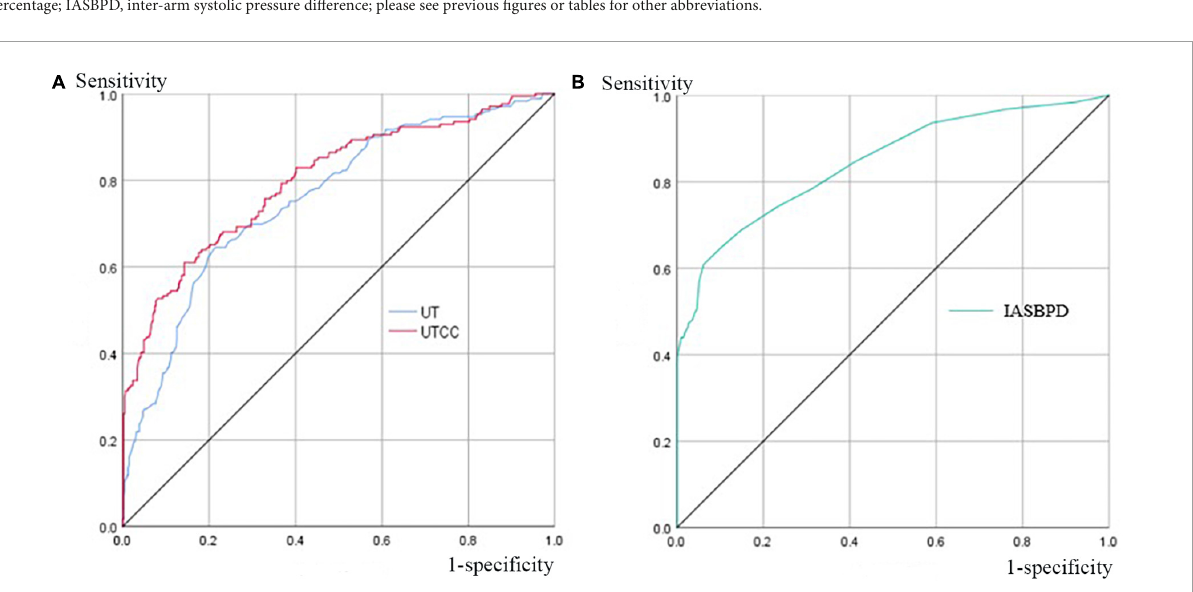
FIGURE3 Area under the curves (AUCs) of UT, UTCC, and IASBPD when SAS ≥ 50%. Panel (A) the UT and UTCC curves when SAS is equal to or greater than 50%, and their corresponding AUC is 0.76 (95% CI: 0.72–0.80) and 0.80 (95% CI: 0.76–0.85) for UT and UTCC, respectively. Panel (B) the IASBPD curve, when SAS is equal to or greater than 50%, corresponds to 0.84 (95% CI: 0.80–0.89). AUC, the area under the curve; CI, confidence interval; please see previous figures or tables for other